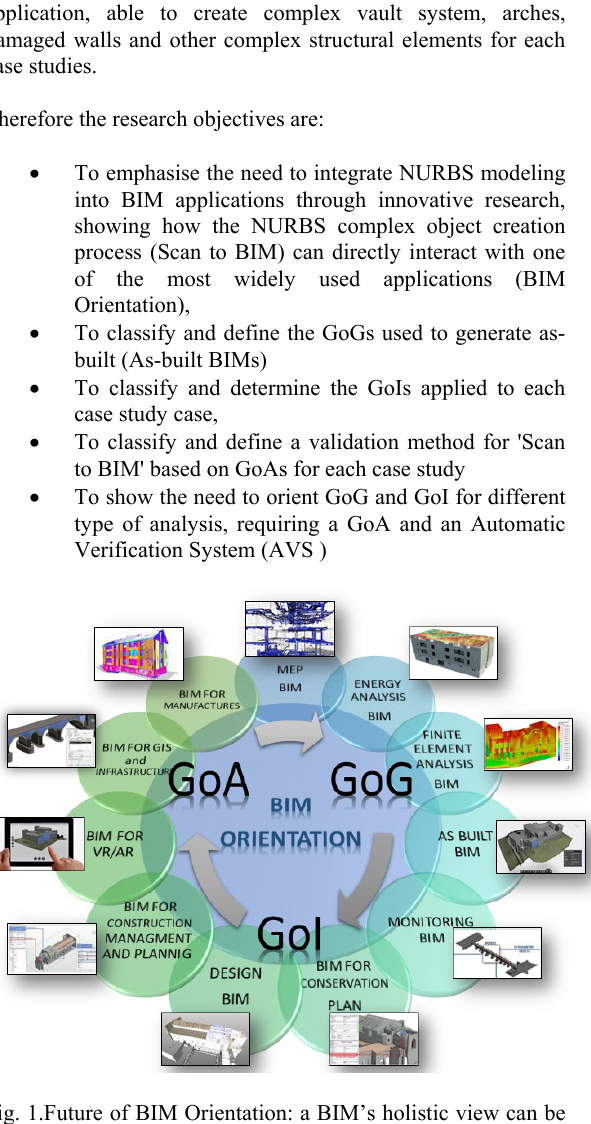
Fig. 1.Future of BIM Orientation: a BIM’s holistic view can be oriented for different disciplines and analysis, stimulating a better dissemination of various results. Each analysis has needed different GoG, GoA and